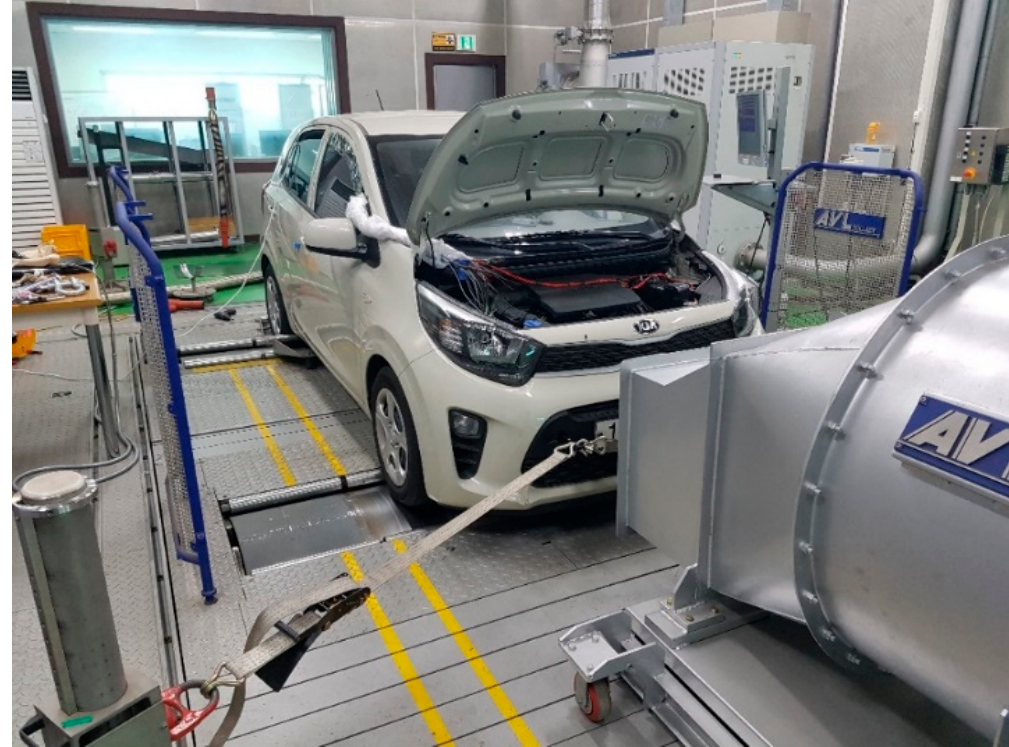
Figure 8. Test on the chassis dynamometer for verification. By comparing the experimental and simulation results the feasibility of the modeling method can be determined.